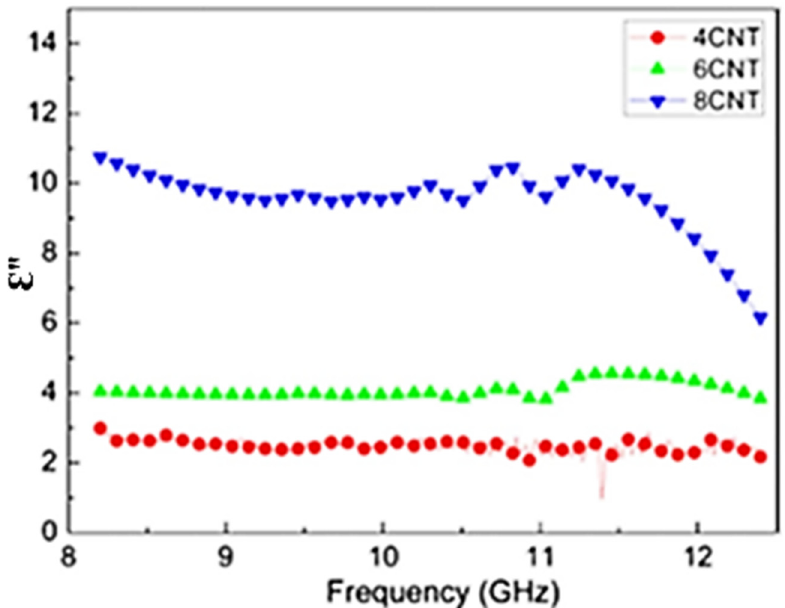
Figure 9. Frequency dependence of dielectric loss of PMMA/CNT nanocomposite foams [53]. Reproduced with permission from Elsevier.